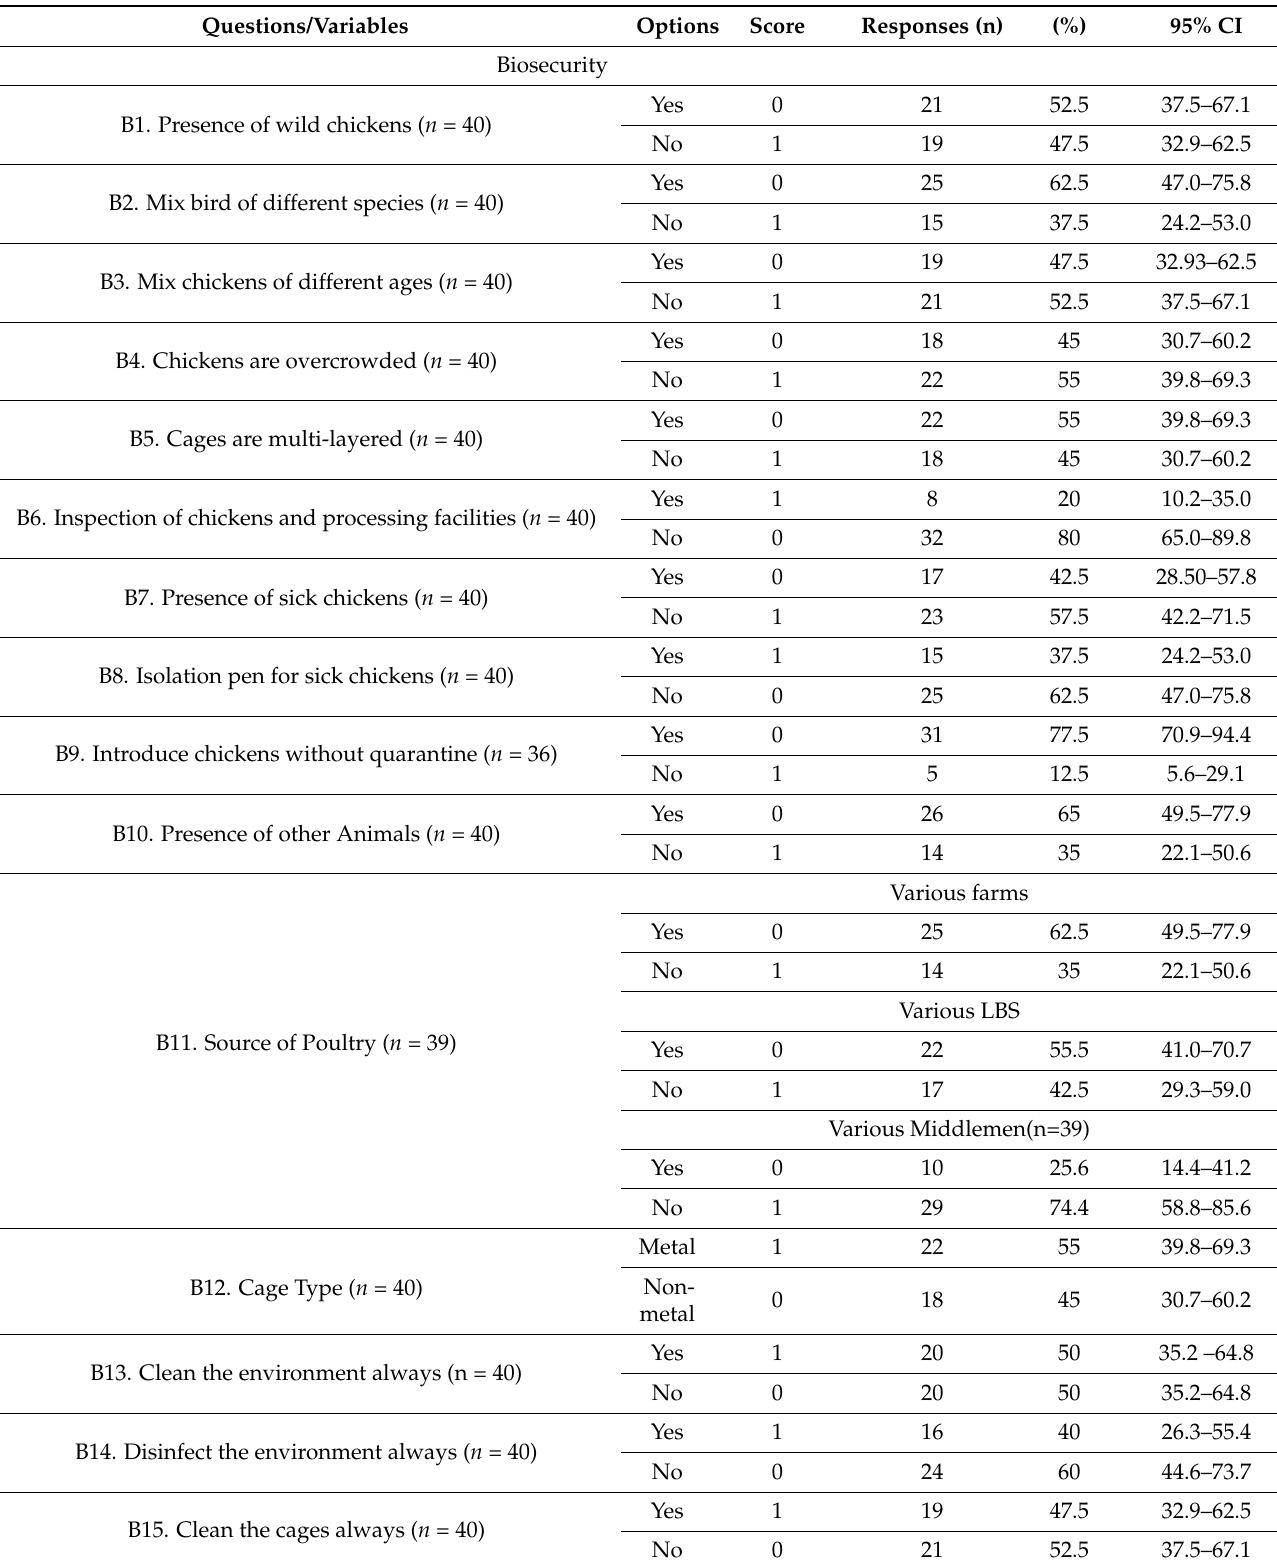
Table 2. The distribution of responses to biosecurity and antimicrobial use question among LBS in Abeokuta, Ogun state ( n =